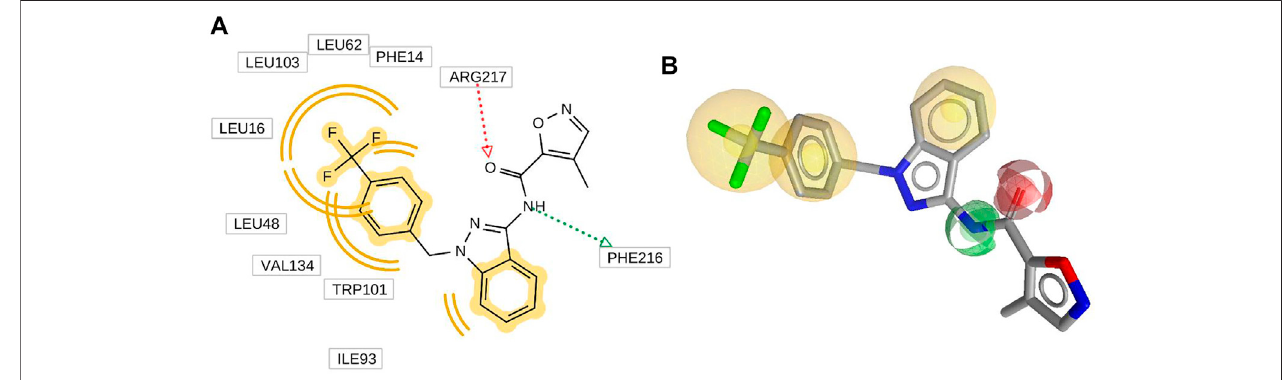
FIGURE 3 | 2D (A) and 3D (B) inhibitor NP-G2-029 with its abstract pharmacophore model generated by LigandScout. Hydrogen bond acceptor (red arrow), hydrogen bond donor (green arrow), hydrophobic interaction, aromatic ring feature interaction (yellow sphere).